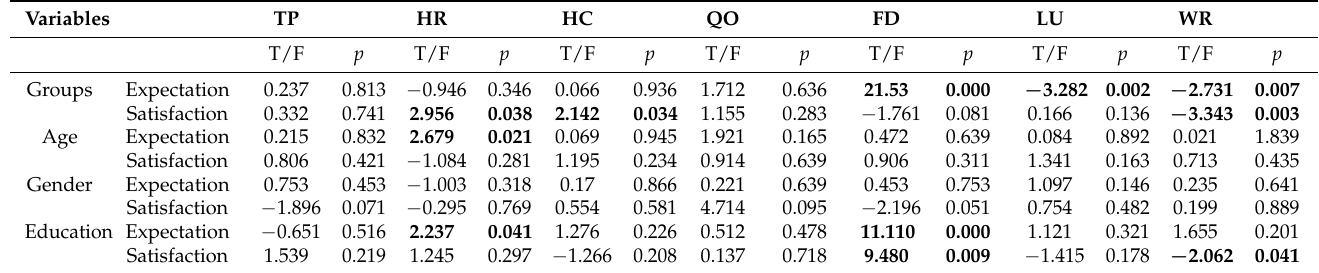
Table 4. Expectation and satisfaction of the functional setting by demographic variables.